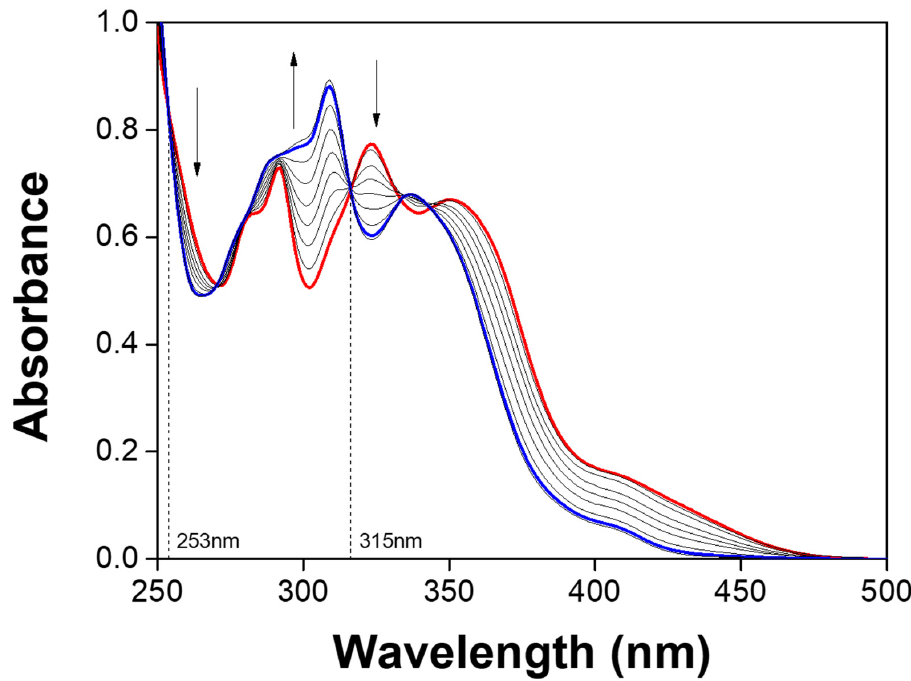
Figure 9. UV–Vis changes of NATB -Al 3+ (30 μ M) with various amounts of H 2 PO 4 − (0–1.5 equiv) in MeOH. The stoichiometry of H 2 PO 4 − toward NATB- Al 3+ was determined by the Job plot ex- periment (Figure S12), which exhibited a 1:1 stoichiometry. The mass spectral analysis displayed a peak of 395.06 ( m/z ), which demonstrated the regeneration of NATB ([ NATB + H + + MeOH] + ; calcd. 395.20) (Figure S13). These outcomes supported the mechanism that the addition of H 2 PO 4 − released Al 3+ from NATB -Al 3+ , which resulted in the loss of fluo- rescence. Based on Li’s method [43], the association constant ( K ) for H 2 PO 4 − with NATB - Al 3+ was calculated as 1.2 × 10 4 M − 1 (Figure S14). The detection limit of NATB- Al 3+ toward H 2 PO 4 − was determined as 1.7 μ M, based on 3 σ /slope (Figure S15). Importantly, NATB is the first fluorescent sensor for the consecutive sensing of Al 3+ and H 2 PO 4 − (Table S1). On the other hand, NATB showed higher detection limits for Al 3+ and H 2 PO 4 − compared to Kumar’s work [32], but it could solely detect H 2 PO 4 − without the interference of HSO 4 − . The reversibility in the response of NATB was verified through the alternative addi- tions of Al 3+ and H 2 PO 4 − (Figure 10). The fluorescence emission of NATB repeated its en- hancing and quenching processes several times without fluorescence efficiency loss. To verify that NATB -Al 3+ is an effective fluorescence probe for H 2 PO 4 − , the interference of other anions was tested (Figure S16). The results indicated that the presence of other ani- ons (1.5 equiv) did not interfere with the fluorescence quenching of NATB -Al 3+ toward H 2 PO 4 − .